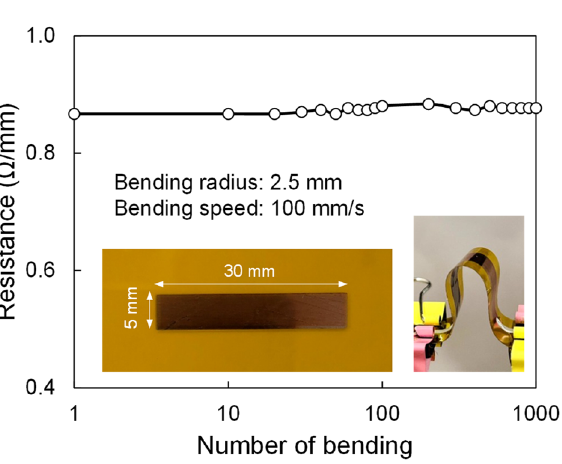
Figure 8. Resistance changes against several bending of the laser-sintered Cu. The bending test was performed at a bending speed of 100 mm/s and bending radius of 2.5